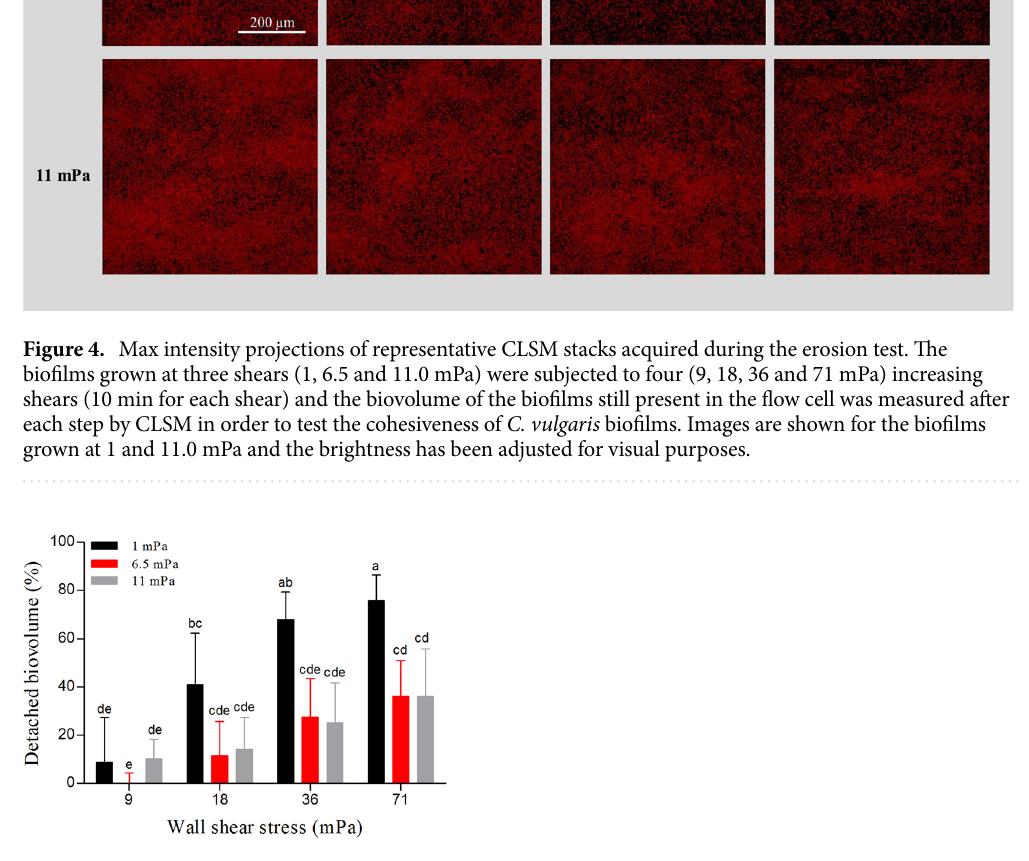
Figure 5. Erosion test performed on the biofilms grown at three different hydrodynamic regimes (1.0, 6.5 and 11.0 mPa). The biofilms were subjected to an increasing set of shears (9.0, 18, 36, and 71 mPa), each step lasted 10 min. The biovolume detached at each shear was calculated with respect to the initial biovolume (pre- erosion test). The results are the mean and standard deviation of at least three independent biological replicates (n ≥ 3). Bars with different letters represent statistically different means ( p < 0.05) as determined by pair-wise comparisons after two-way ANOVA considering both the growth shear stress and the shear stress applied during the erosion stress as